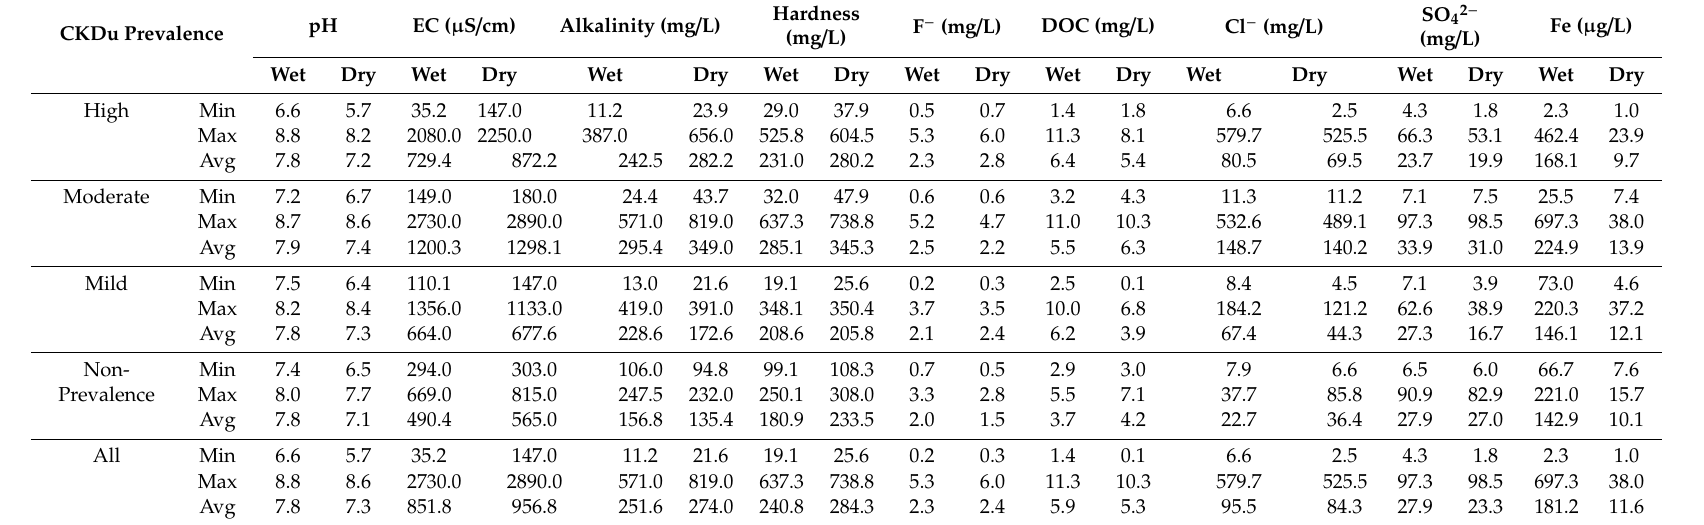
Table 1. Summary of the hydro geochemical data of two